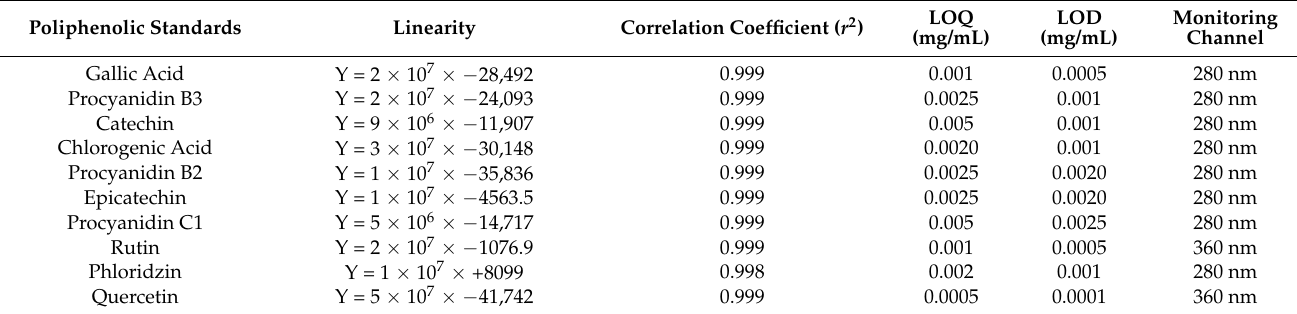
Table 5. Linearity and sensitivity of the HPLC-DAD